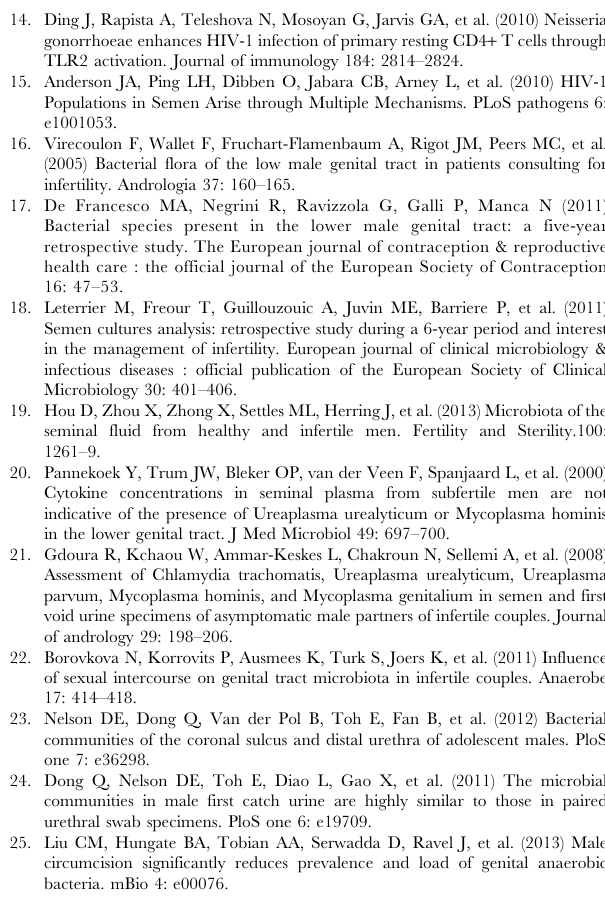
Figure S4 Changes in specific semen bacteria after one and six months of ART. The semen bacterial changes after ART did not involve those that were unique to HIV-uninfected men. Pedobacter increased significantly in HIV-infected men after ART ( Panel A ). Whereas among semen bacteria that were unique to HIV-uninfected men, Enhydrobacter showed peaking after one month of ART ( Panel B ) and Pseudonocardia peaking six months of ART ( Panel C ). Bifidobacterium showed no appreciable increase ( Panel D ). Text S1 Supporting information. This file includes four supporting information tables. Table S1. Prevalence and propor- tional abundances of semen bacteria in HIV-uninfected men and in HIV-infected men prior to and after antiretroviral therapy. Table S2. Results from the indicator analysis showing semen bacterial genera based on HIV infection status. Table S3. Semen bacteria unique in HIV-infected men after six months of antiretroviral treatment. Table S4. Loadings from the principal component analysis of pro-inflammatory cytokines that correlated with semen bacterial